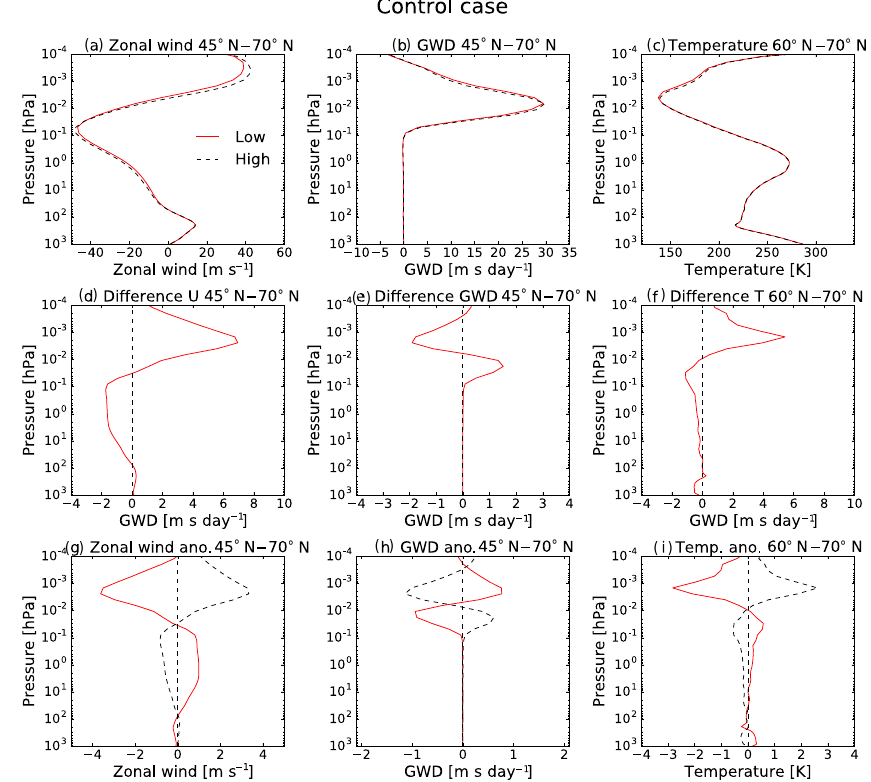
Figure 4. The July zonal wind (a, d, g) and the GW drag (b, e, h) between 45–70 ◦ N and the temperature (c, f, i) between 70–90 ◦ N for anomalously low and high temperatures in the winter stratosphere (1–10hPa, 60–40 ◦ S) (a–c) and the differences between them (d–f) and their anomalies (g–i) , for the case where there are GWs in the winter hemisphere. The red continuous lines show the results for anomalously low temperatures and the black dashed lines show the results for the anomalously high